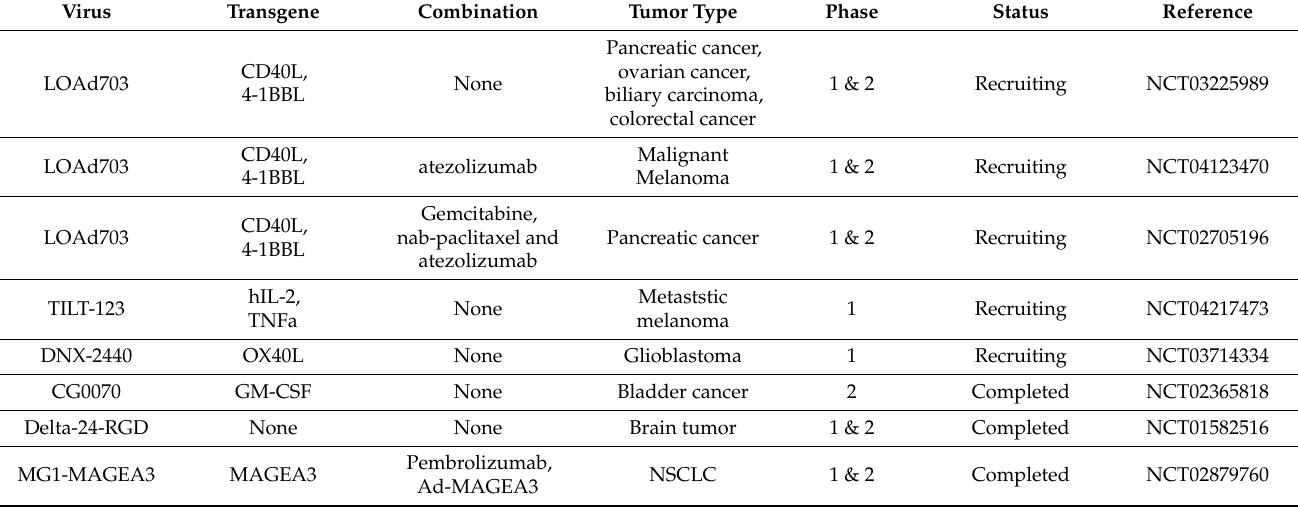
Table 3. Examples of clinical trials with